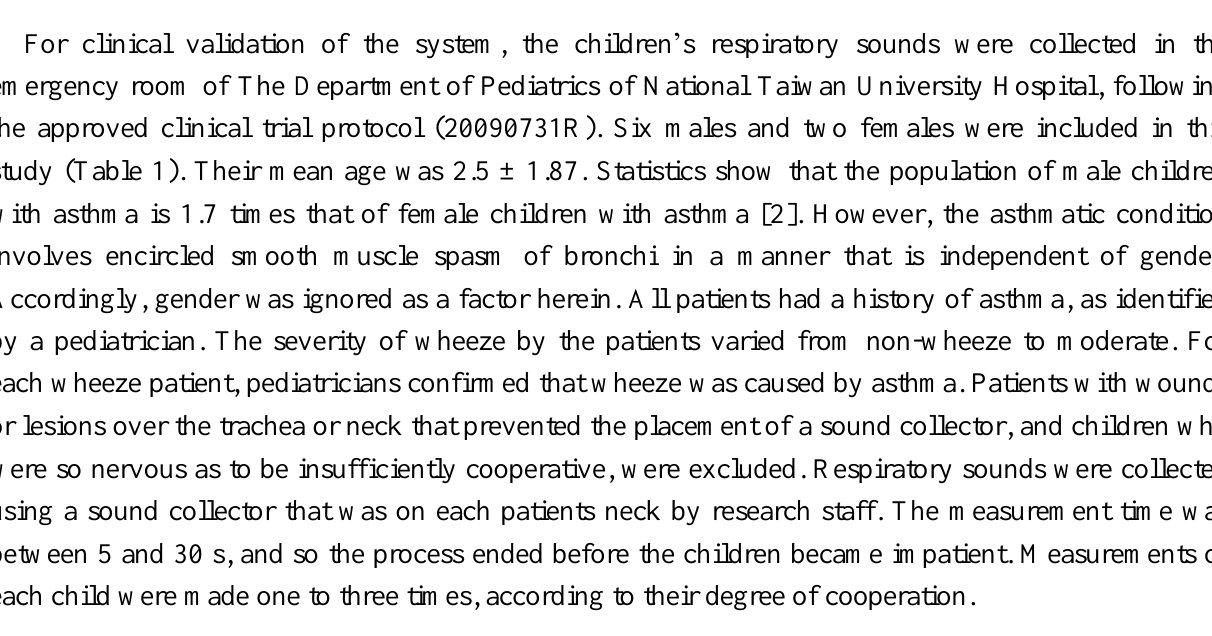
Table 1. The summarization of subjects of the